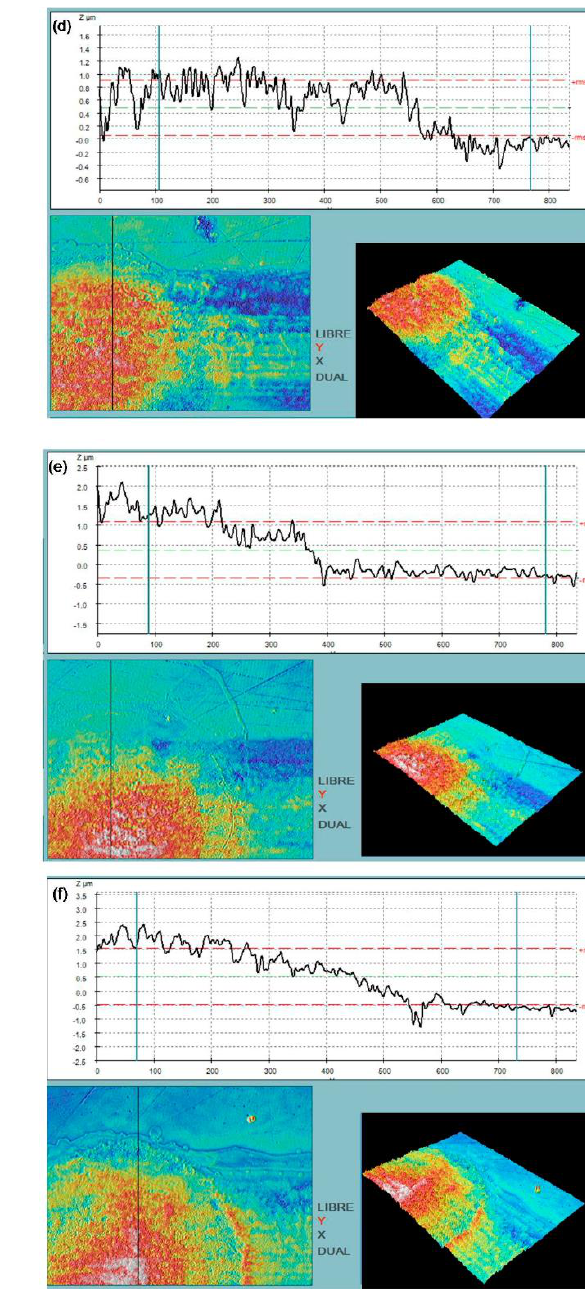
Figure 4. Confocal relief images and profilometry of WE printed with ( a ) 6-, ( b ) 12-, ( c ) 18-layer of SWCNT-5 ink ( left ) and ( d ) 6-, ( e ) 12-, ( f ) 18-layer of SWCNT-7.5 ink ( right ).